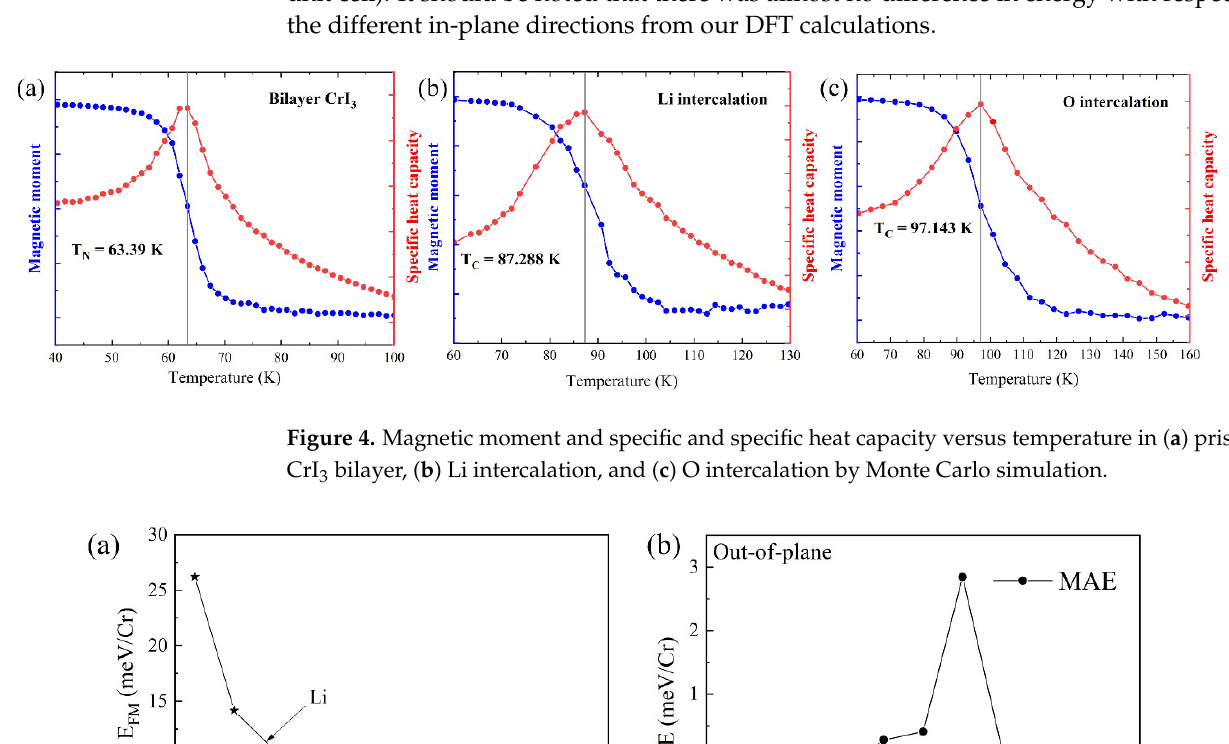
Figure 4. Magnetic moment and specific and specific heat capacity versus temperature in ( a ) pristine CrI 3 bilayer, ( b ) Li intercalation, and ( c ) O intercalation by Monte Carlo simulation.